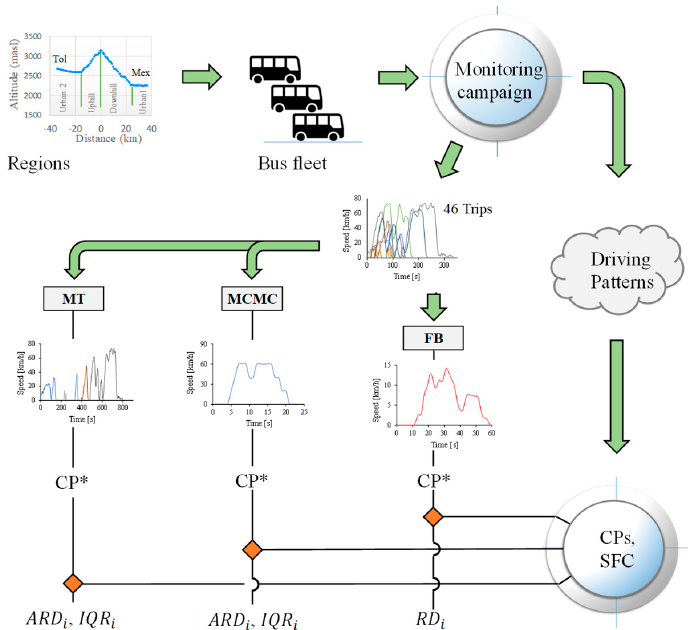
Figure 2. Illustration of the methodology followed to compare three alternatives to construct representative driving cycles.